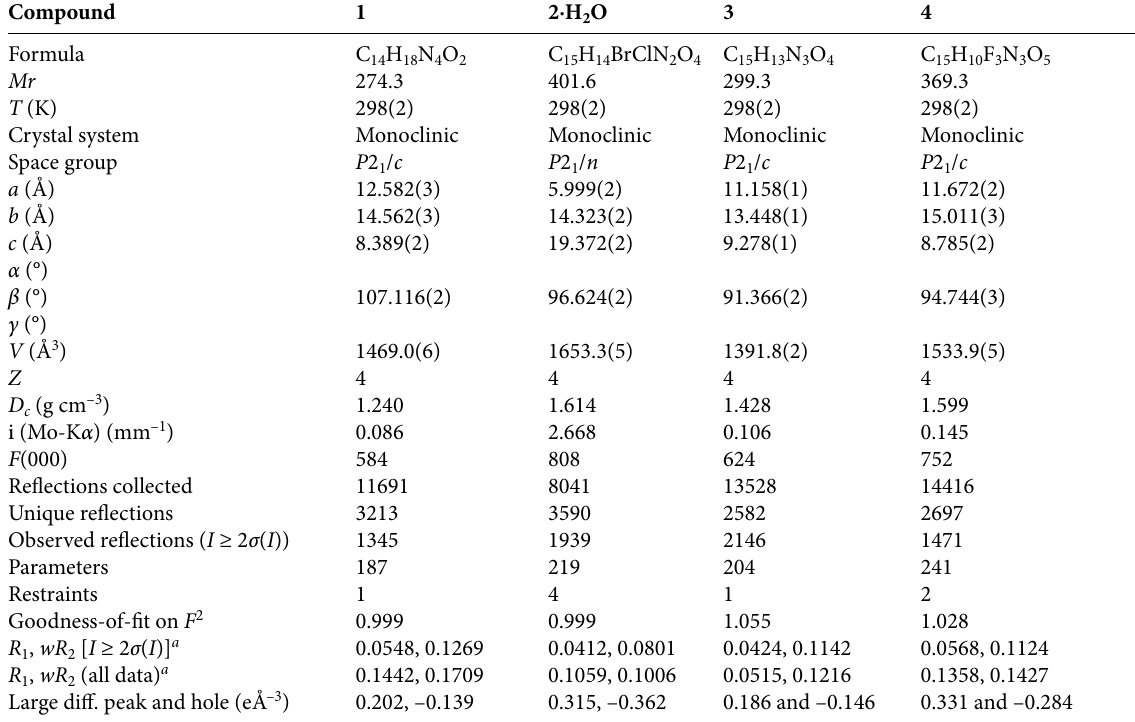
Table 1. Crystallographic and experimental data for compounds 1 – 4